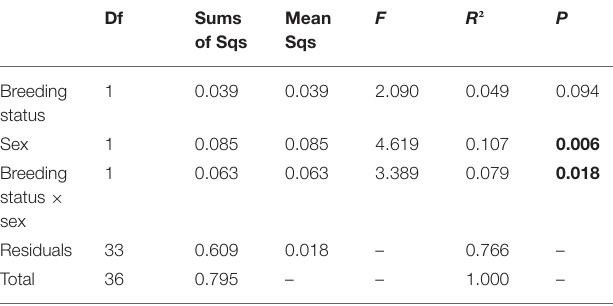
TABLE 2 | Analysis of variance using distance matrices (ADONIS) with 50,000 permutations based on Bray-Curtis distances on the effects of the breeding status (outbred and inbred individuals), sex and their interaction on the chemical phenotype, i.e., profile of putative cuticular hydrocarbons, of adult Phaedon cochleariae ( N = 9–10 per breeding status and